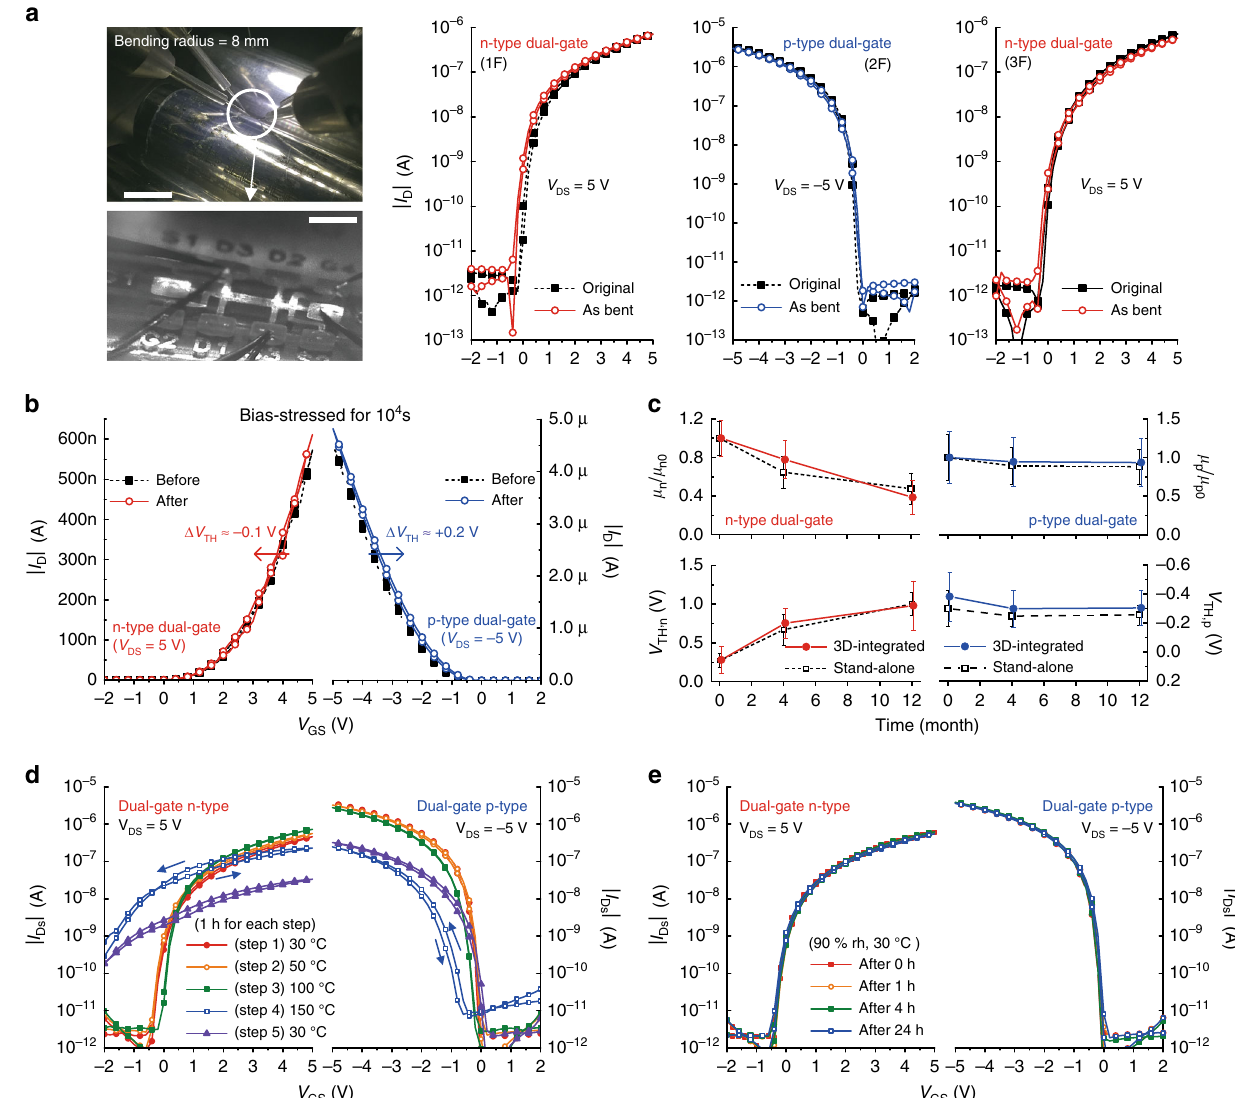
Fig. 8 Mechanical, electrical, long-term, and environmental reliabilities a Images of the stacked 3-T device under bending test (white dotted area is magni fi ed) and its saturation transfer characteristics as bent on a curved surface (scale bars in the top and bottom images are 1 cm and 1 mm, respectively). b Shift of the saturation transfer characteristics of the printed stand-alone complementary transistors after electrical bias stress for 10,000 s (at V GS = V DS = 5 V for the n-type and − 5 V for the p-type). c Year-long observation on the carrier mobilities and threshold voltages of the stand-alone and stacked 2-T devices ( μ n , μ p : carrier mobility, μ n0 , μ p0 : initial carrier mobility, V TH,n , V TH,p : threshold voltage, error bars represent standard deviation). d Shift of the saturation transfer characteristics of the complementary dual-gate transistors under consecutive fi ve thermal stress steps. e Shift of the saturation transfer characteristics of the complementary dual-gate transistors under a humid environment (90% rh, 30 °C) for 24 h (rh: relative